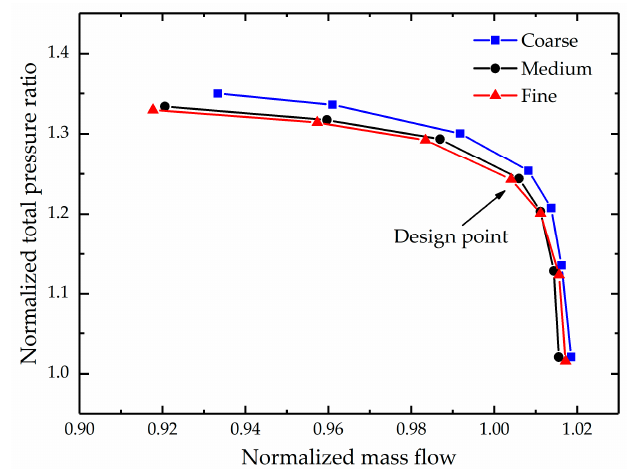
Figure 12. Aerodynamic performance of three mesh densities.